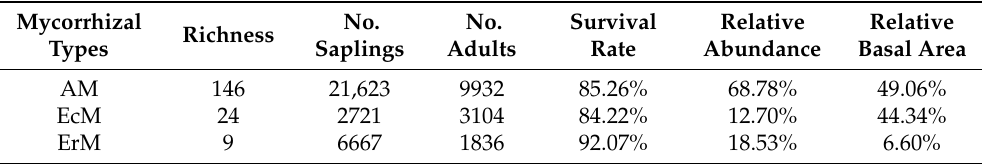
Table 1. Summary information on species mycorrhizal